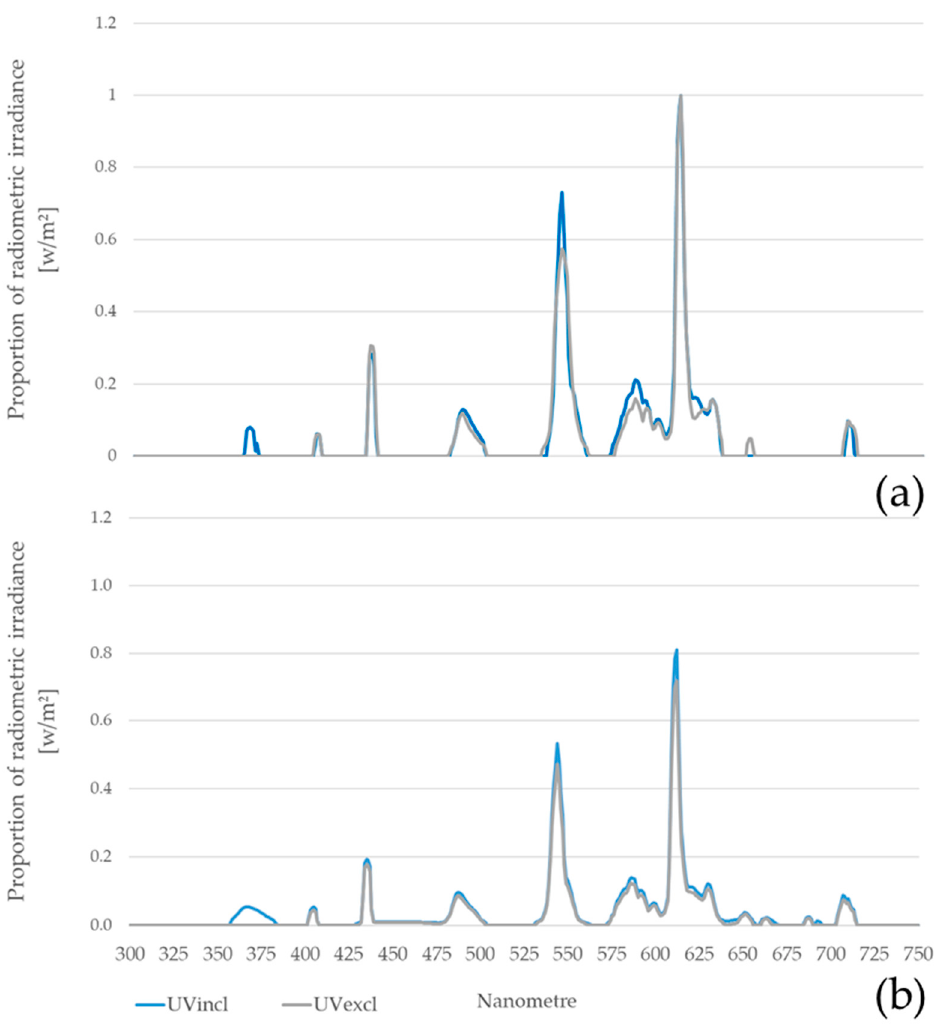
Figure 2. Light spectrum during rearing (a) and laying (b) with (UVincl) and without (UVexcl) additional UV-A light with peaks in the wavelength in yellow (about 525–550 nm) and red (about 600–625 nm). A peak of ultraviolet light (about 350–380 nm) was only measured in the UVincl group. During rearing, the measured mean light intensity (lux) was 25.3 ± 1.51 lux to 26.9 ± 2.33 lux in the UVincl group and 25.9 ± 1.51 lux to 27.6 ± 1.84 lux in the UVexcl group, therefore meeting the European recommended minimum light intensity of 20 lux (Figure 3). At the start of laying (18th / 19th week of life), the average light intensity in the two lighting groups was 64.0 ± 6.60 lux (UVincl group) and 60.0 ± 4.38 lux (UVexcl group), respectively. In general, during production, the light intensity was continually reduced in both light groups to 2.41 ± 0.14 lux (UVincl group) and 2.4 ± 0.13 lux (UVexcl group) at the end of this study (last reading at week 48). The reduction in the light intensity in both barns was necessary because of feather pecking and cannibalism in both groups and was carried out in pecking and, therefore, still in line with EU